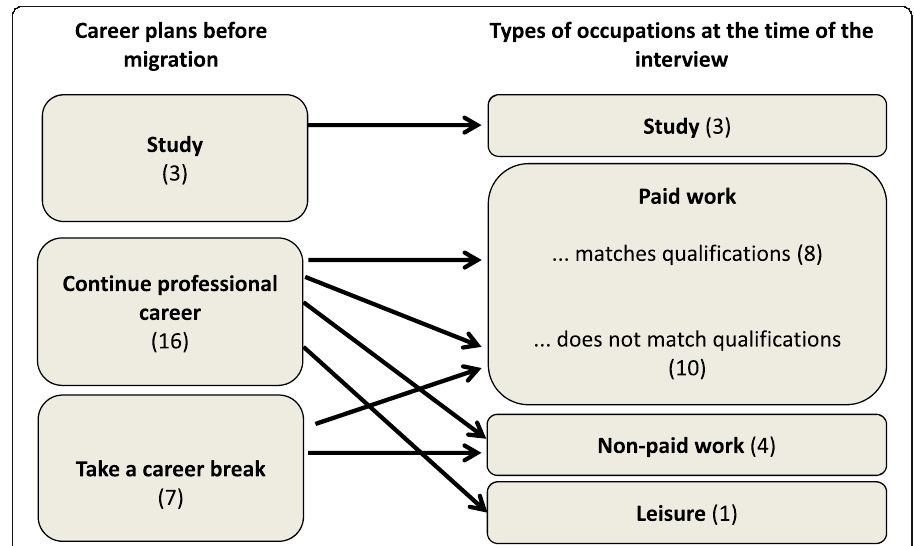
Fig. 1 Career plans and types of occupation. The number in brackets indicates the number of interviewees in the sample. Source: own interviews, n =